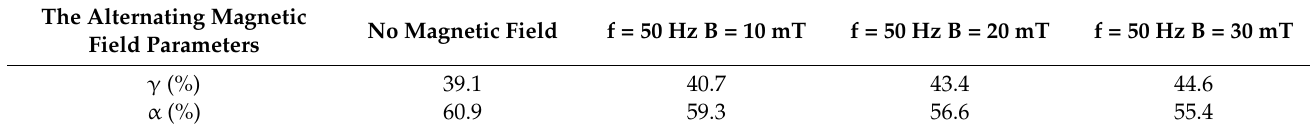
Table 2. Austenite and ferrite contents in WM under an alternating magnetic field.